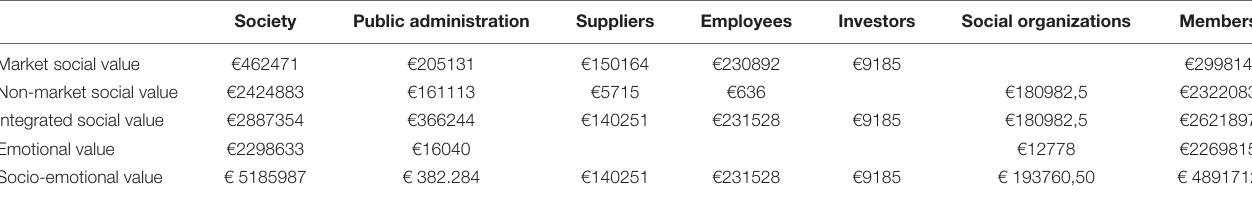
TABLE 2 | Socio-emotional